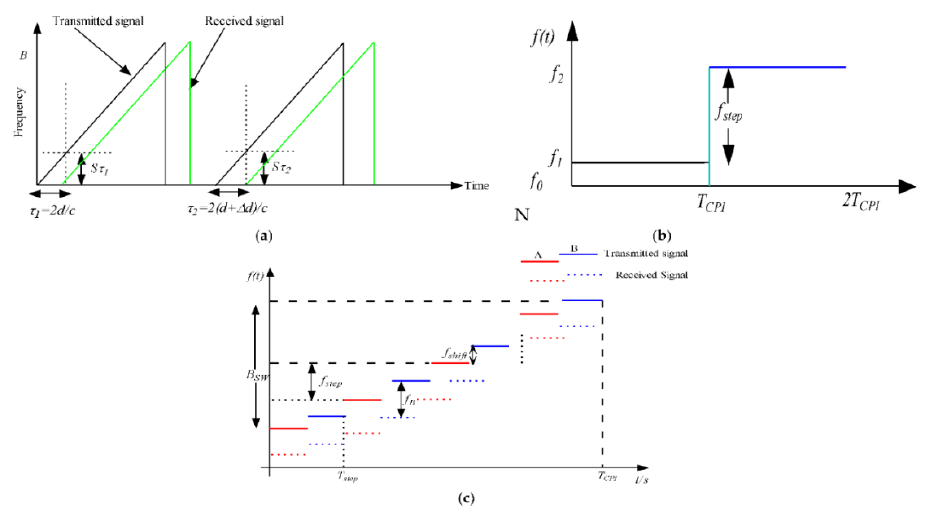
Figure 1. Range and velocity estimation schemes. ( a ) linear frequency modulated continuous waveform (LFMCW) scheme [52], ( b ) Frequency Shift Keying (FSK) waveform scheme [67], and ( c ) Multiple Frequency Shift Keying (MFSK) waveform system [68].